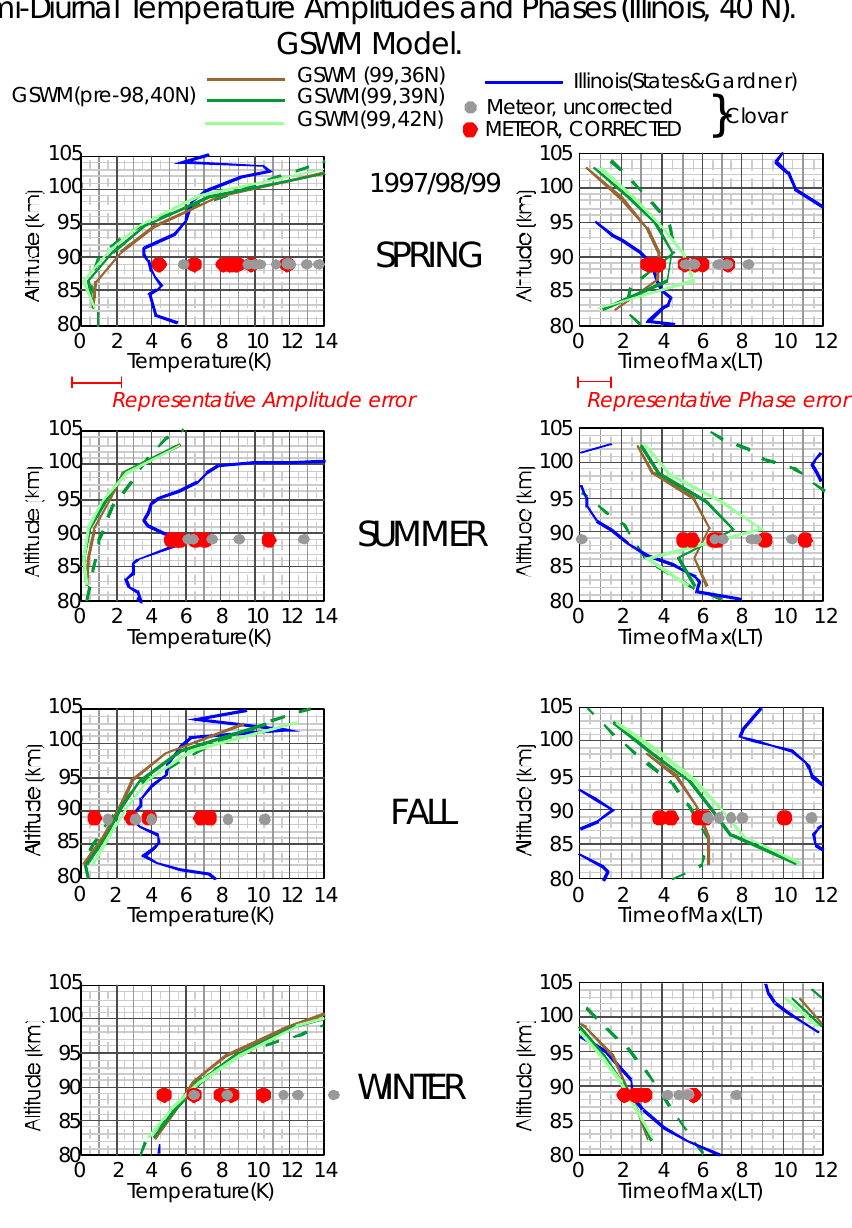
Fig. 7 Fig. 7. As for Fig. 6, but for the semidiurnal